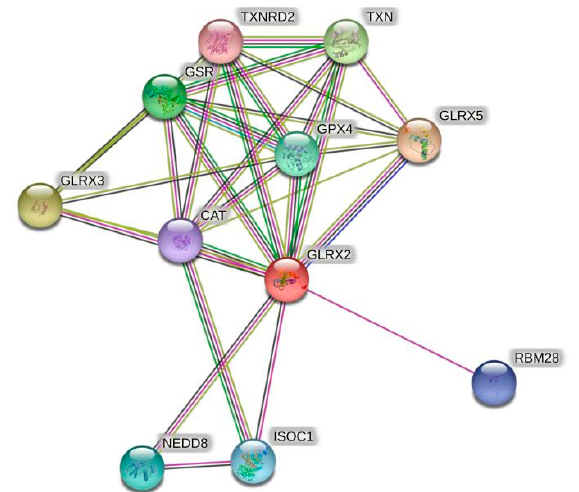
Figure 1. Grx2 protein interactions networks. The red dots represent the target protein Grx2. Other colored dots represent proteins that interact with Grx2. The names of all proteins are abbreviated to the top right of the dots.